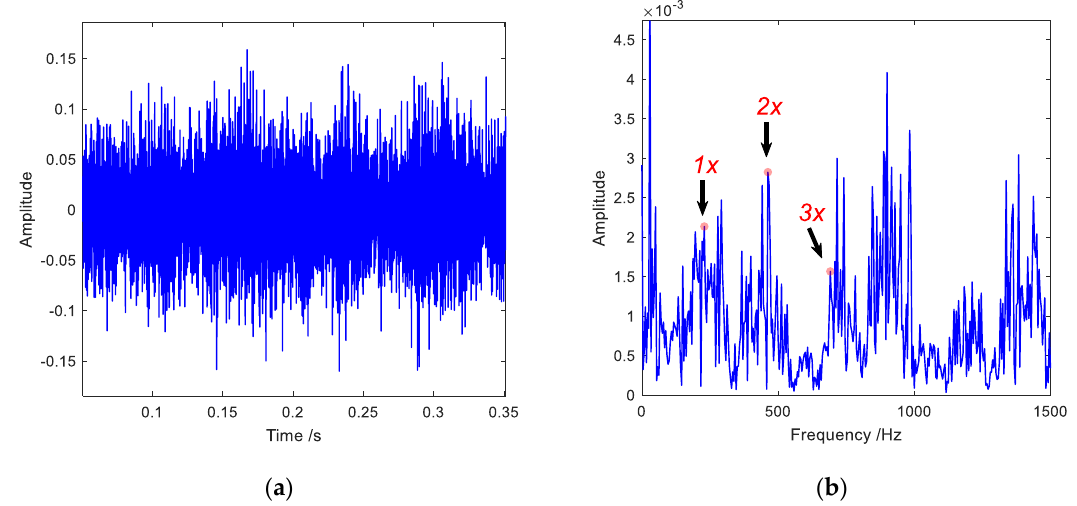
Figure 9. Results based on maximum correlated kurtosis deconvolution (MCKD): ( a ) The deconvolution signal after filtering; ( b ) the frequency spectrum of the deconvolution.